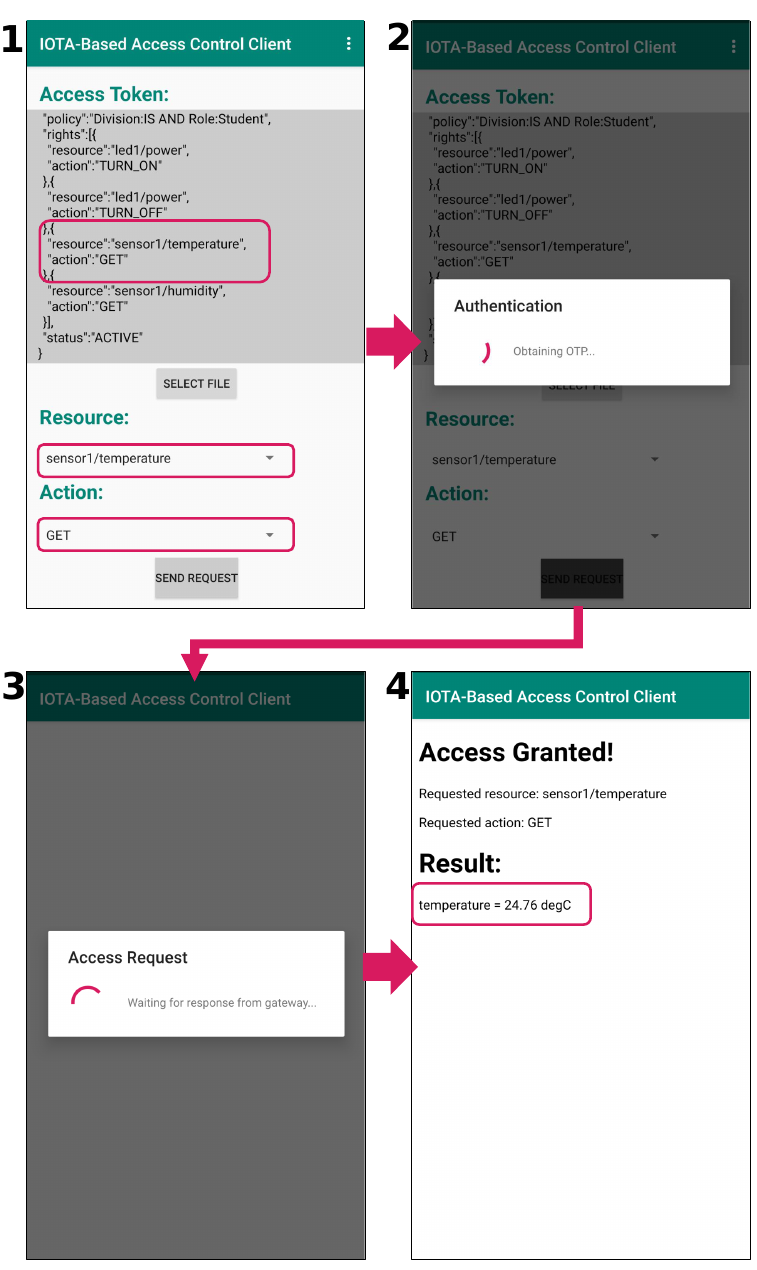
Figure 13. Granted